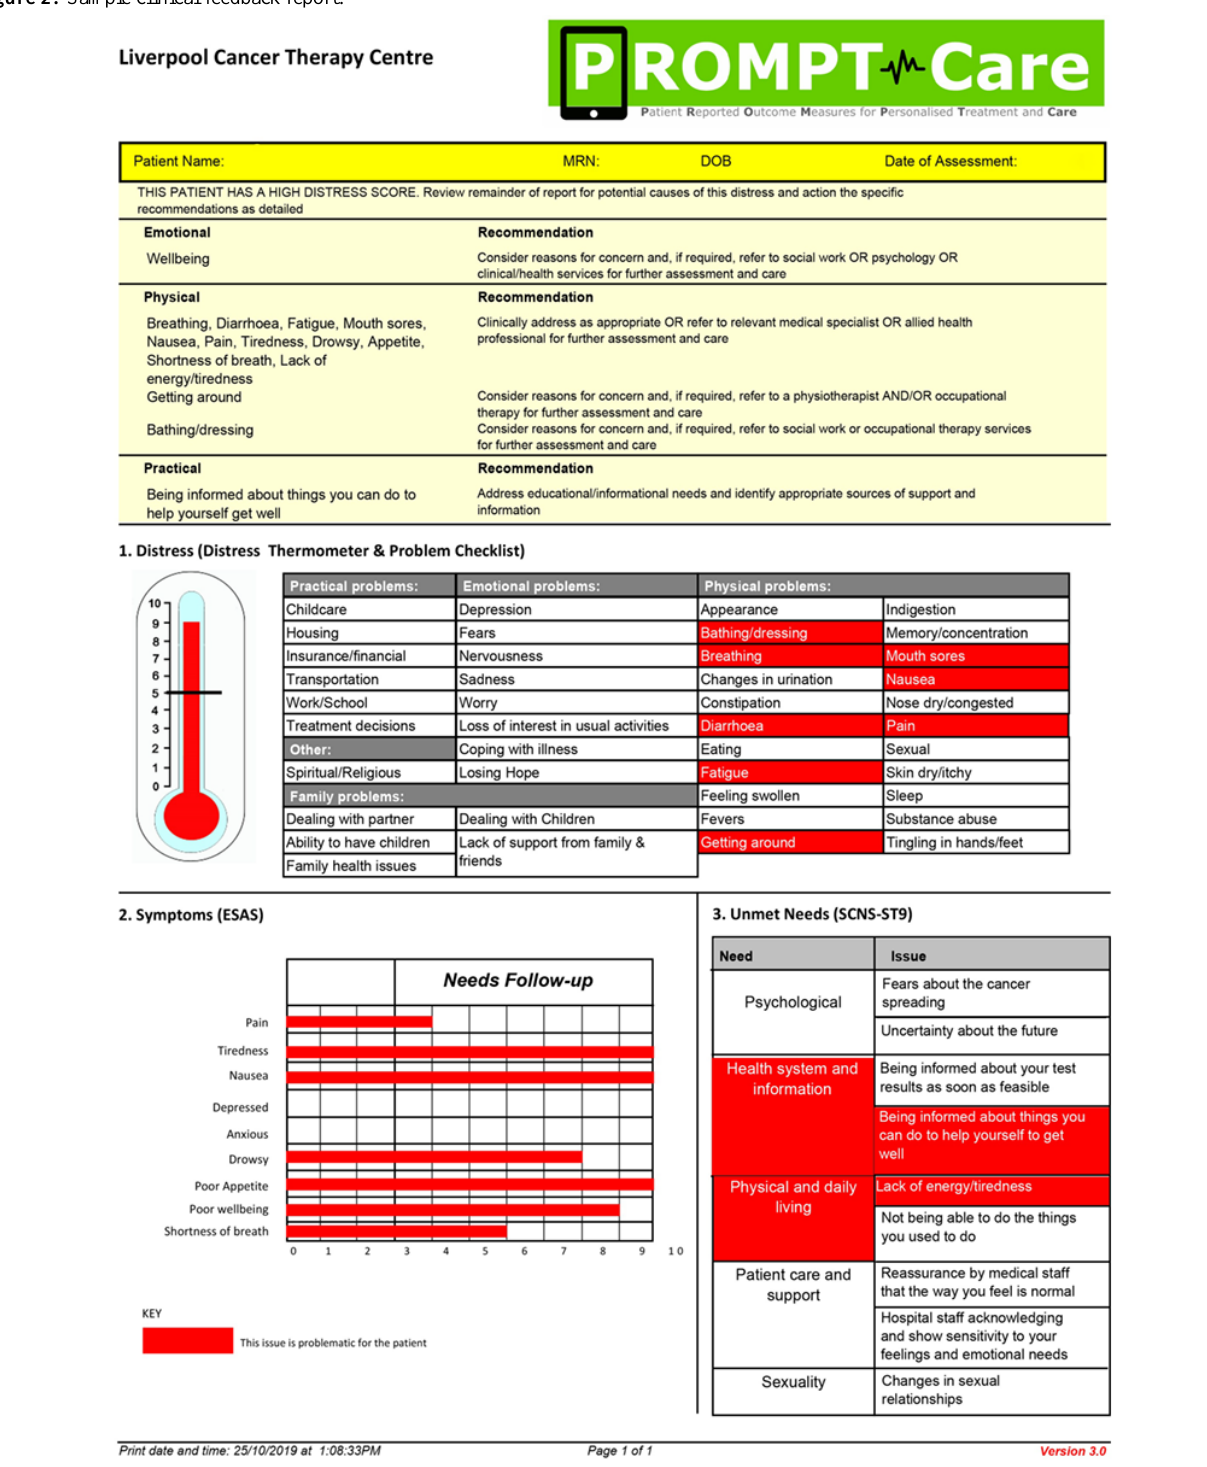
Figure 2. Sample clinical feedback